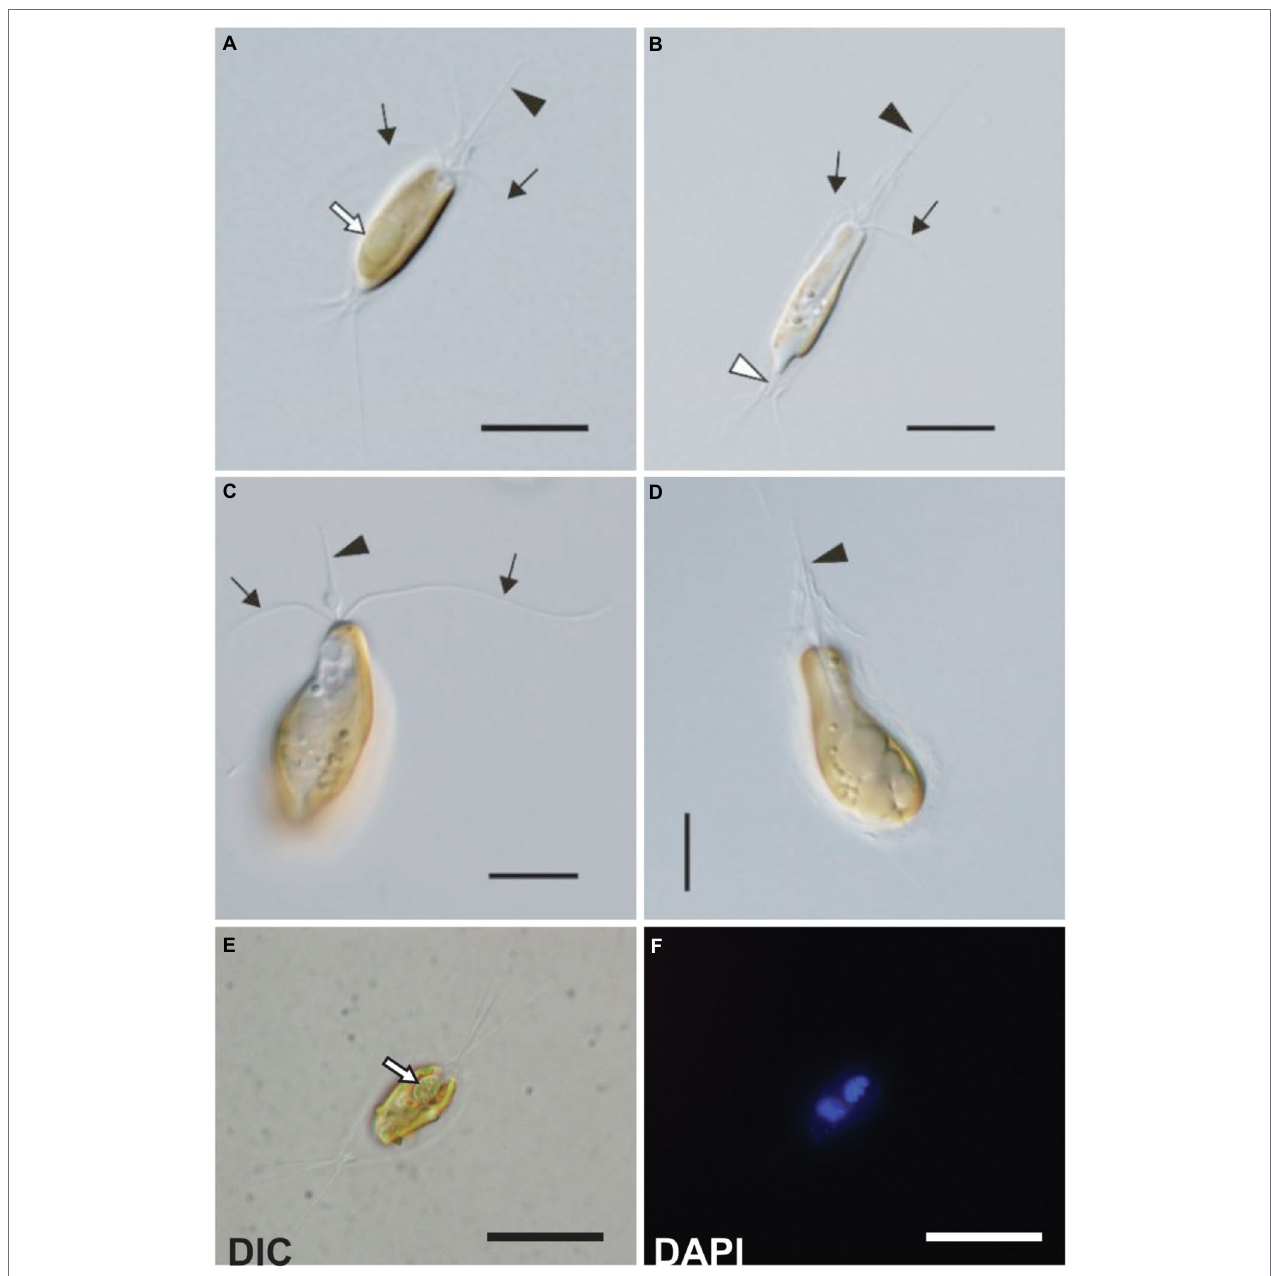
FIGURE 1 | Light microscopy images of the C. parkeae stage of B. bigelowii . Two strains KC1-P2 (A , B , E , and F) and KC15-24 (C and D) are shown. Cells possessed a haptonema (black arrowheads), two flagella (black arrows), and a distinctive projecting structure at the posterior end (white arrowhead). (A) KC1-P2 with its endosymbiont. KC1-P2 possessed a single endosymbiont at the posterior of the cell (white arrow). (B) KC1-P2 without its endosymbiont. KC1-P2 lost its endosymbiont at the beginning of cultivation. (C and D) KC15-24 did not possess an endosymbiont. A swelling of the haptonema is visible at the base. (E , F) Fluorescence microscopy images of KC1-P2 stained using DAPI. Blue fluorescence of the endosymbiont shows the presence of DNA. Scale bars represent 10 μ